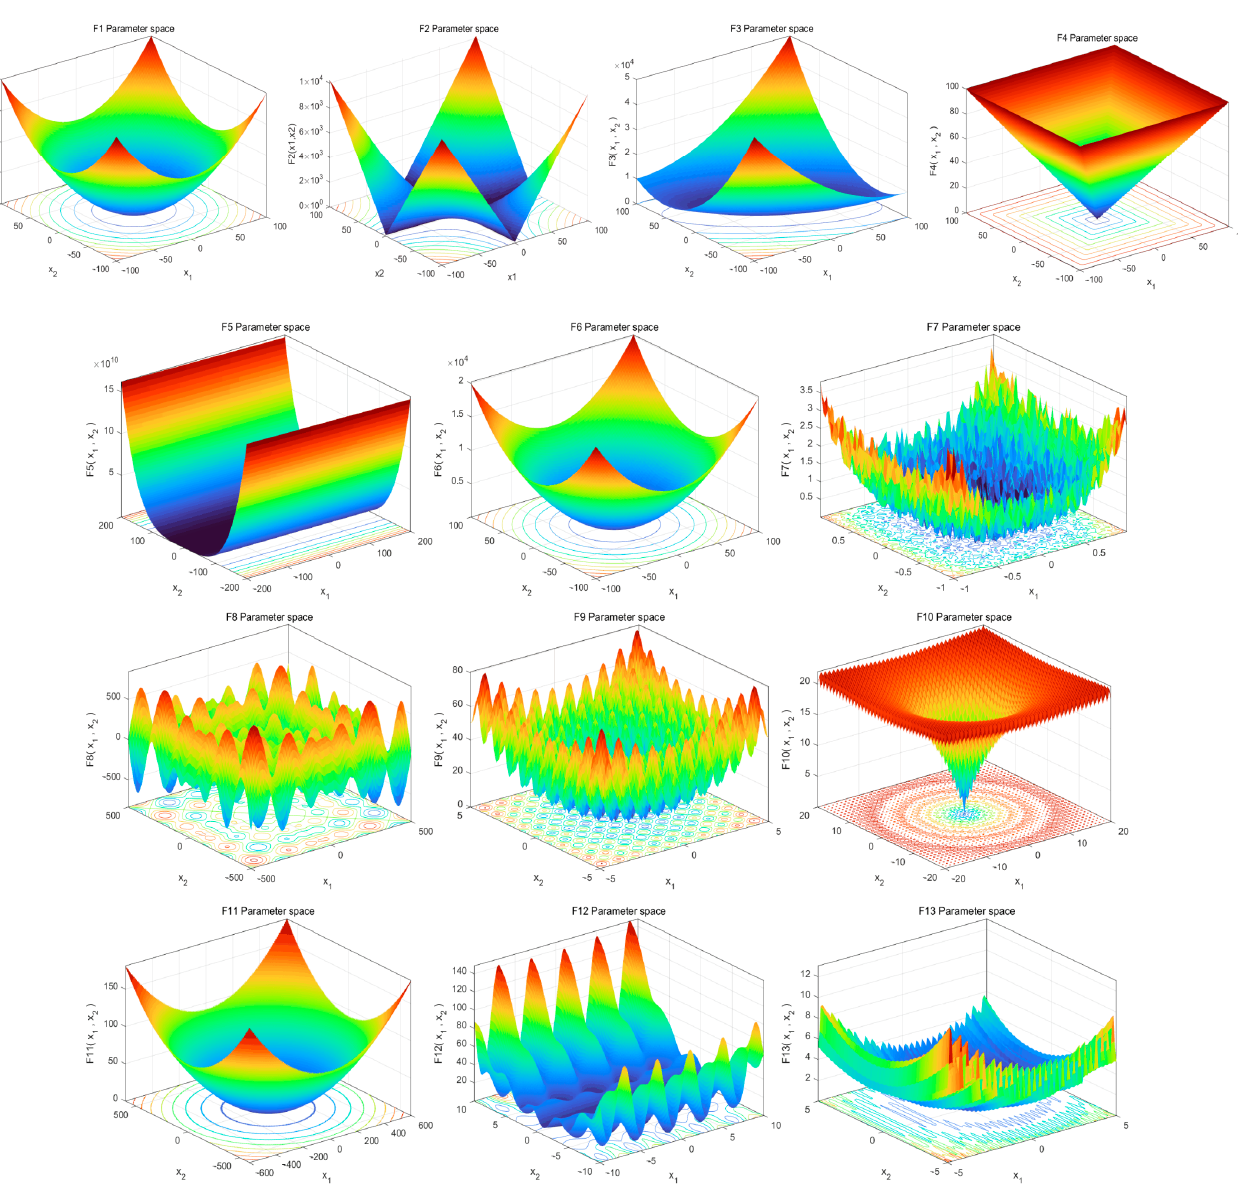
Figure 2. Schematic diagram of 23 standard reference functions.